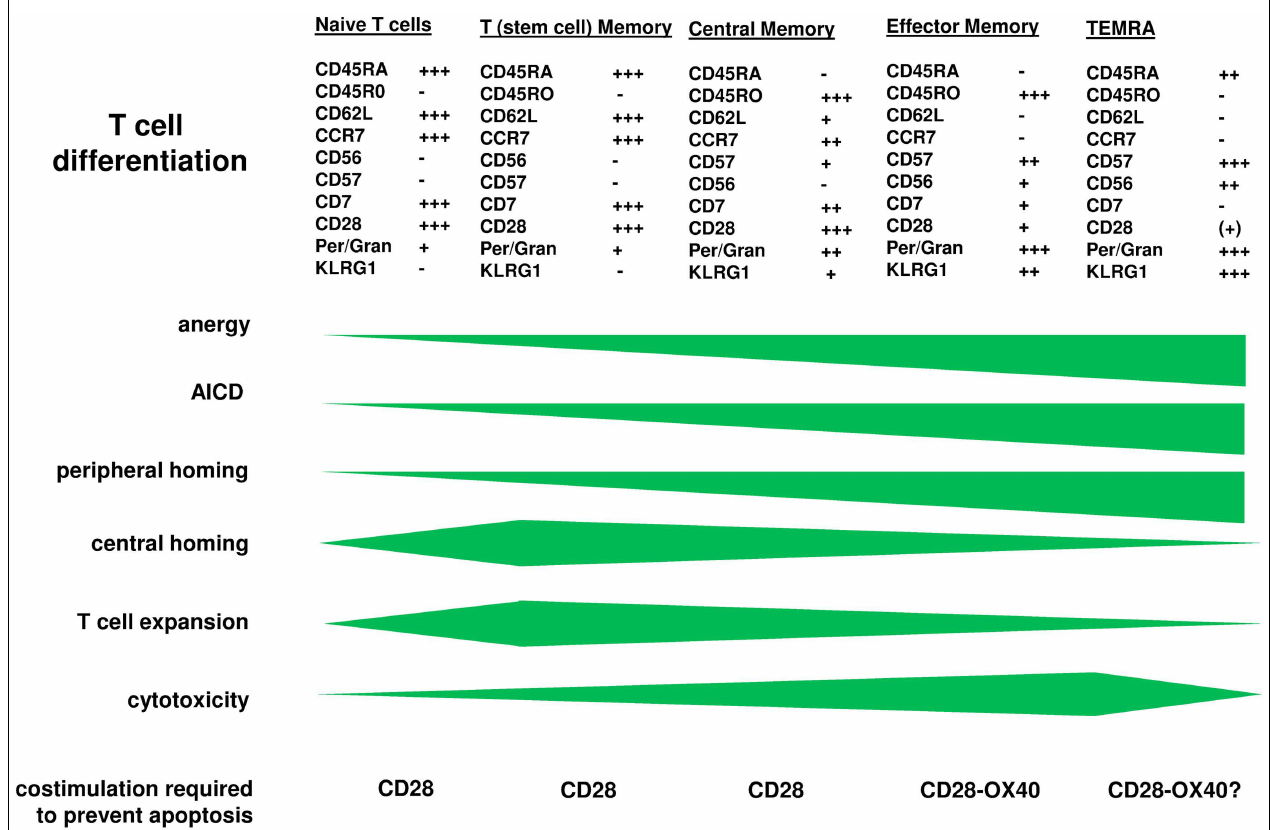
signals for being protected from anergy and activation-induced cell death. On the other hand, those more matured cells have increased cytolytic potential making them highly effective in the anti-tumor attack. EngineeringT cells with a combined CD28-OX40 CAR which prevents apoptosis of matured CCR7 − T cells is one of the upcoming strategies to solve the situation and to improve the anti-tumor efficacy in the